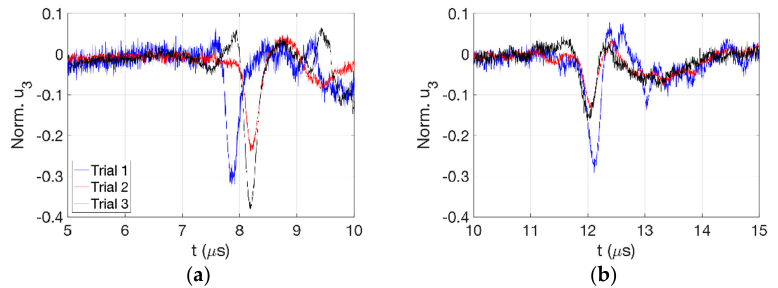
Figure 10. Three different Ti-6Al-4V AM depositions for process parameter set A in Table 1 received at ( a ) point 1 and ( b ) point 2.